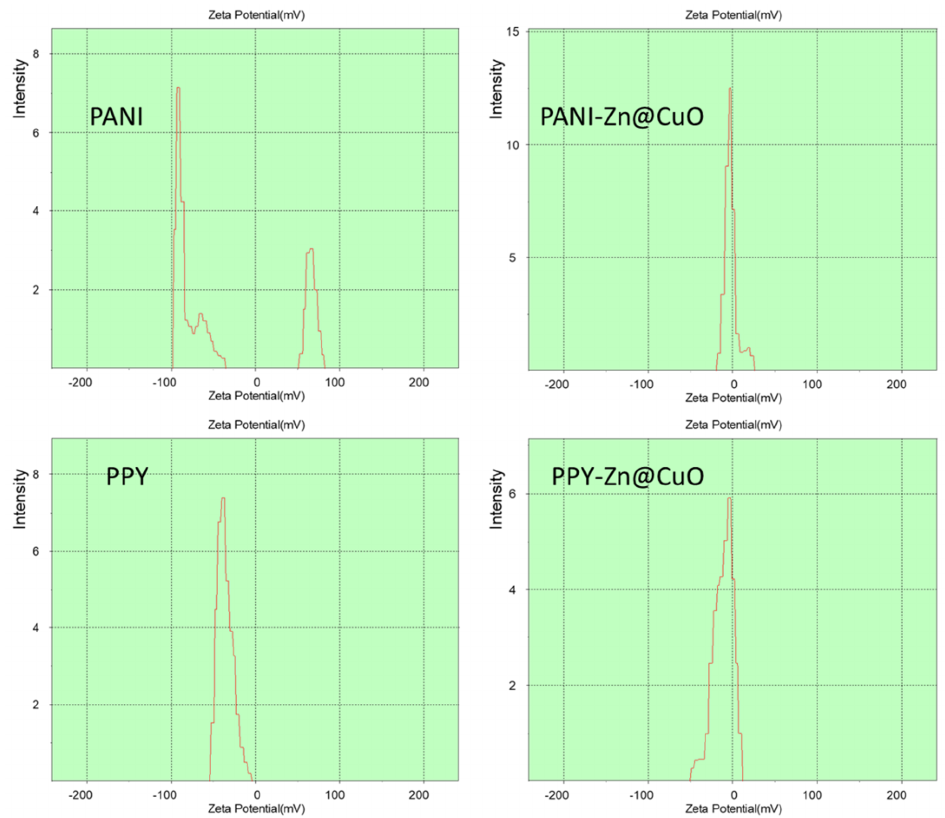
Figure 4. Zeta potentials of PANI, PANI-Zn@Cu-O, PPY, and PPY-Zn@CuO.